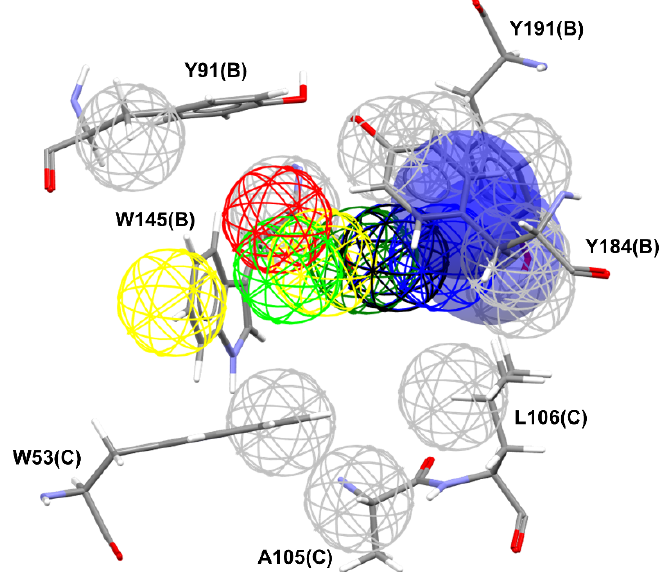
Figure 8. Pharmacophore map of the most well ‐ behaved ligands from α 7 receptor dbCICA model combined with exclusion spheres from α 7 receptor. Meshed spheres are shown as follows: exclusion spheres in gray; hydrogen bond acceptor regions in red; non ‐ planar rings in dark green; planar rings in light green; hydrophobic regions in yellow; positively charged regions in black; hydrogen bond donor regions in blue. Blue opaque spheres represent directions of hydrogen bond donor atoms. Hydrogen bond donor regions include non ‐ classical and electron ‐ deficient atoms of hydrogen bonds.